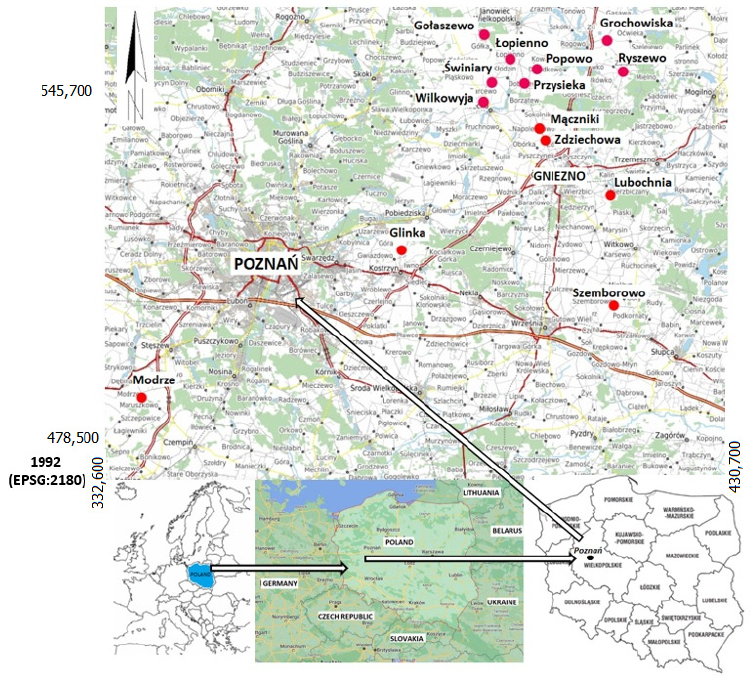
Figure 2. Map showing the location of the analyzed villages. Scale 1:100,000. The preparatory work involved scanning the objects in the above-mentioned 1:25,000 maps and loading the scans into the MikroMap 4.4 (Coder) program for further analysis. Characteristic markers defining the border were numbered for each object on its boundary line. The points were determined only on those parts of the borders that did not follow natural boundaries and were close to an arc. Using MikroMap, the coordinates of the points on the border line were determined. Calculations were made in WinKalk 3.7 (Coder). Given the scanning and reading errors of the points in the 1:25,000 map, the lengths of the radii and arcs as well as calculated coordinates and position errors of the points were recorded in the nearest tens of meters, whereas the angular measurements were made to the nearest 1